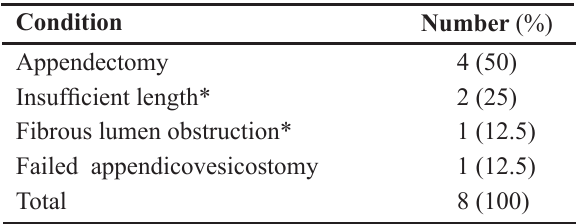
Table 2 – Causes of unavailability of